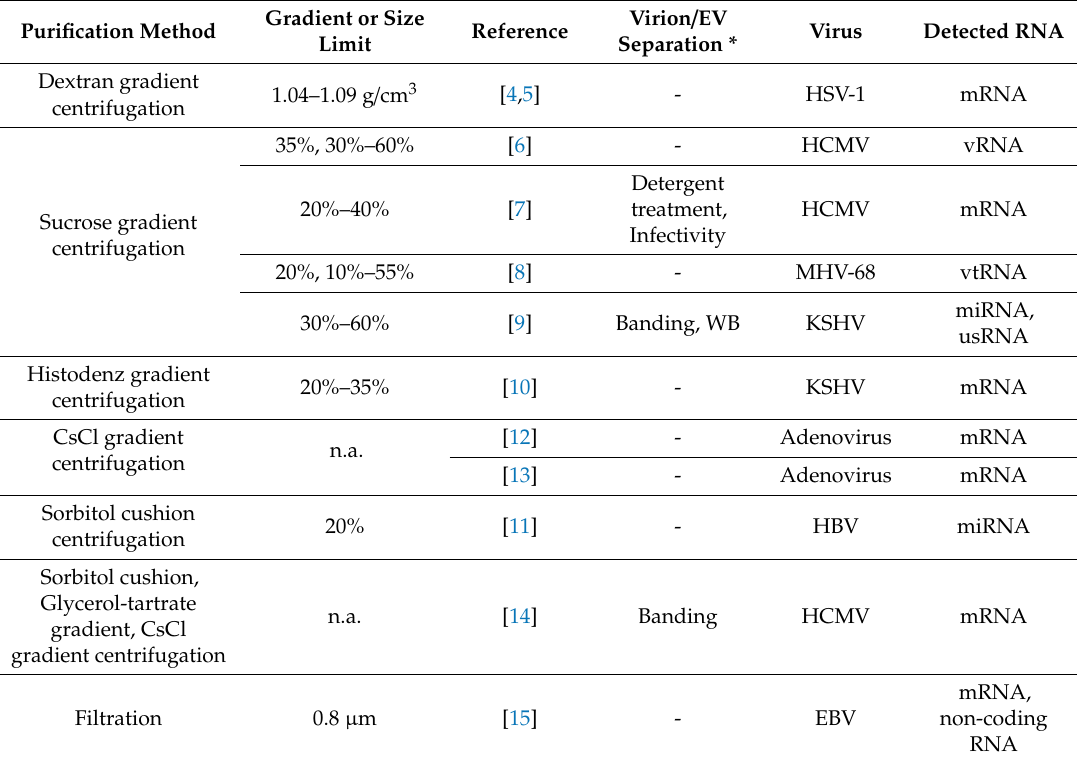
Table 2. Studies showing that RNA co-isolated with virion preparations were classified based on the purification methods used. * When indicated, the corresponding experiments were performed intending to rule out EV contamination. HSV-1: herpes simplex viruses 1, HCMV: human cytomegalovirus, MHV-68: murine gammaherpesvirus 68, KSHV: Kaposi’s sarcoma herpesvirus, HBV: hepatitis B